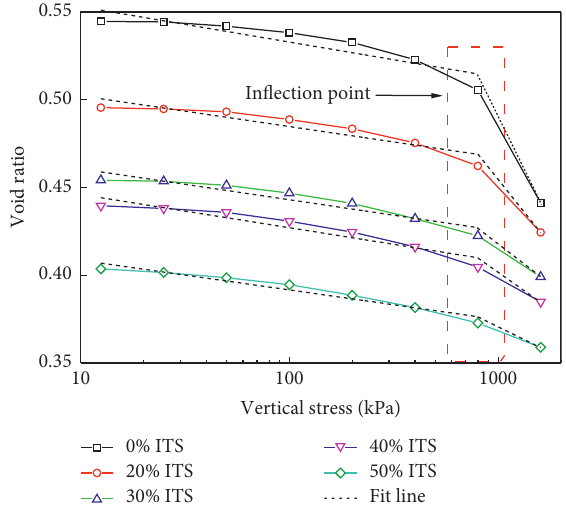
Figure 9: e -log ( p ) curves of the ITS treated specimens with dif- ferent contents.